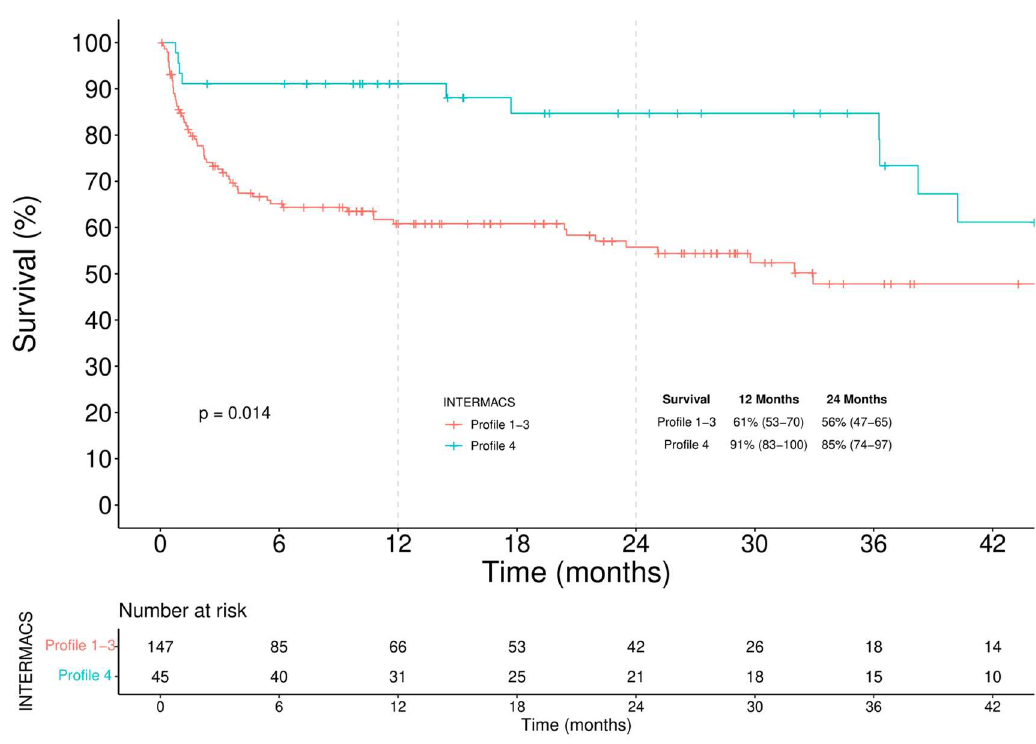
Figure 2. Kaplan-Meier analysis of survival stratified by baseline INTERMACS patient profile. Table 3. Postoperative outcomes and major adverse events of overall ( n = 192), INTERMACS Profile1–3 ( n = 147) and Profile 4 ( n = 45) patients.